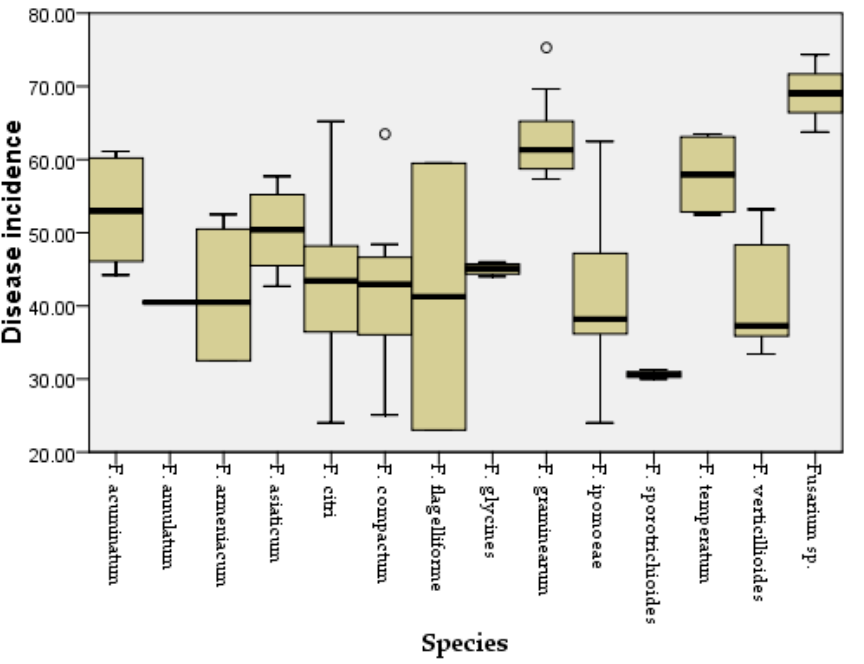
Figure 6. Disease incidence for maize leaves inoculated with different Fusarium species. Outliers are represented by a hollow circle.